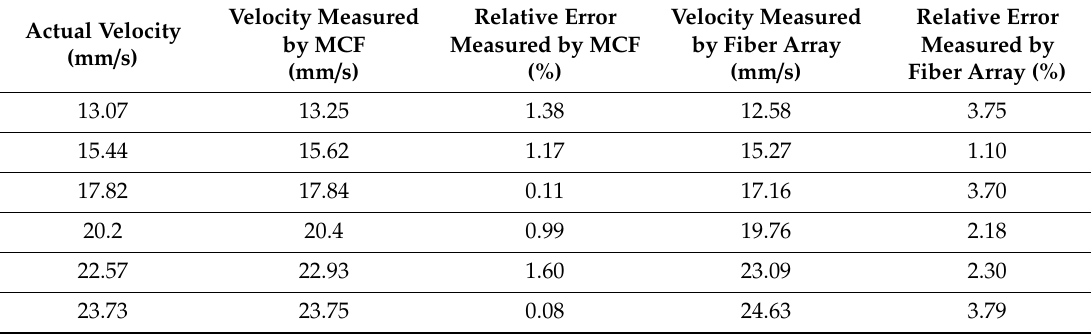
Table 2. ComparisonoftheparticlevelocitymeasurementbetweentheMCFprobeandthefiberarrayprobe. Table 2. Comparison of the particle velocity measurement between the MCF probe and the fiber Actual array probe.